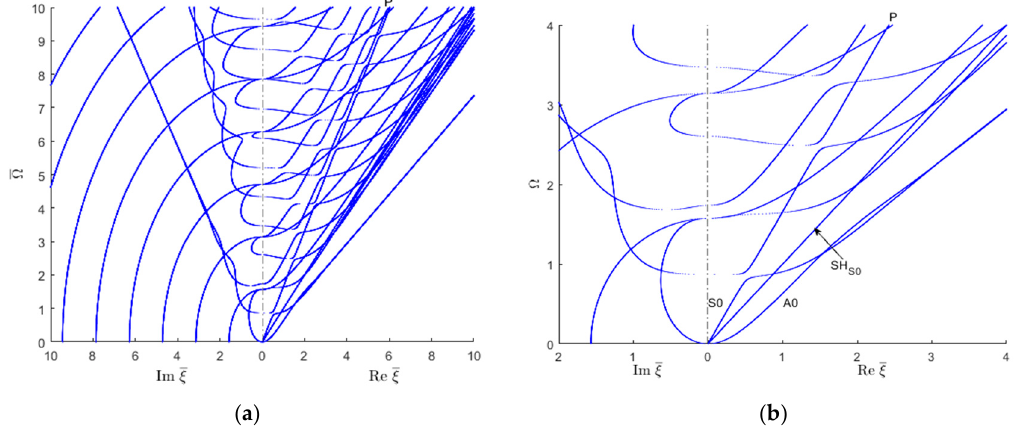
Figure 10. Real and imaginary wavenumber trajectories for low transverse stiffness, high shear stiffness, orthotropic material: ( a ) overall plot; ( b ) zoom in near the origin.